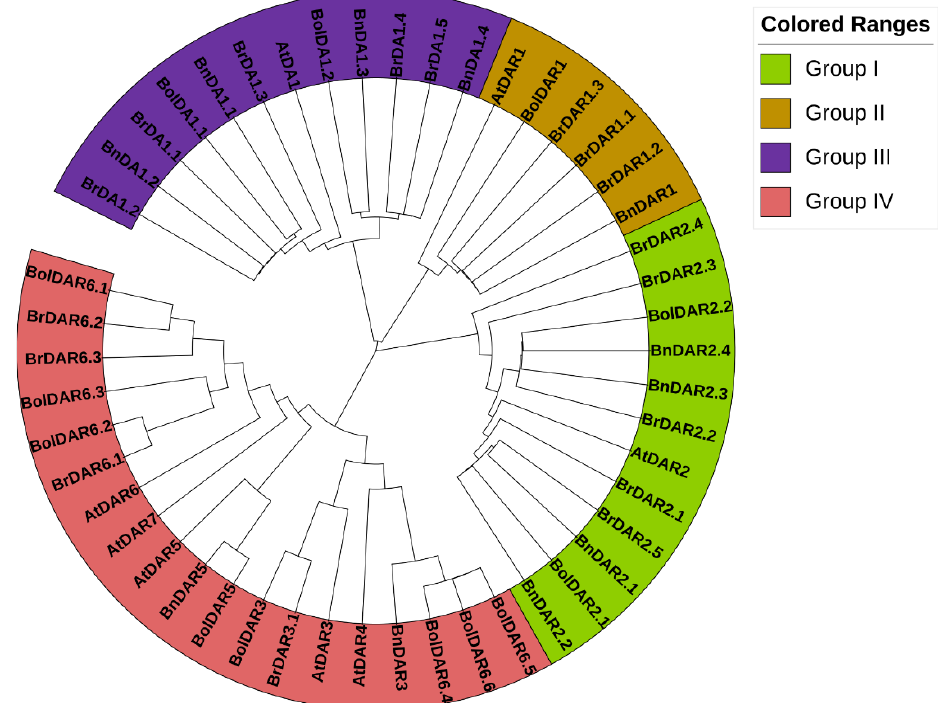
Figure 1. Phylogenetic analysis of 17 DA1 & DAR proteins from B. rapa , 11 from B. napus , 13 from B. oleracea, and 7 from A. thaliana .